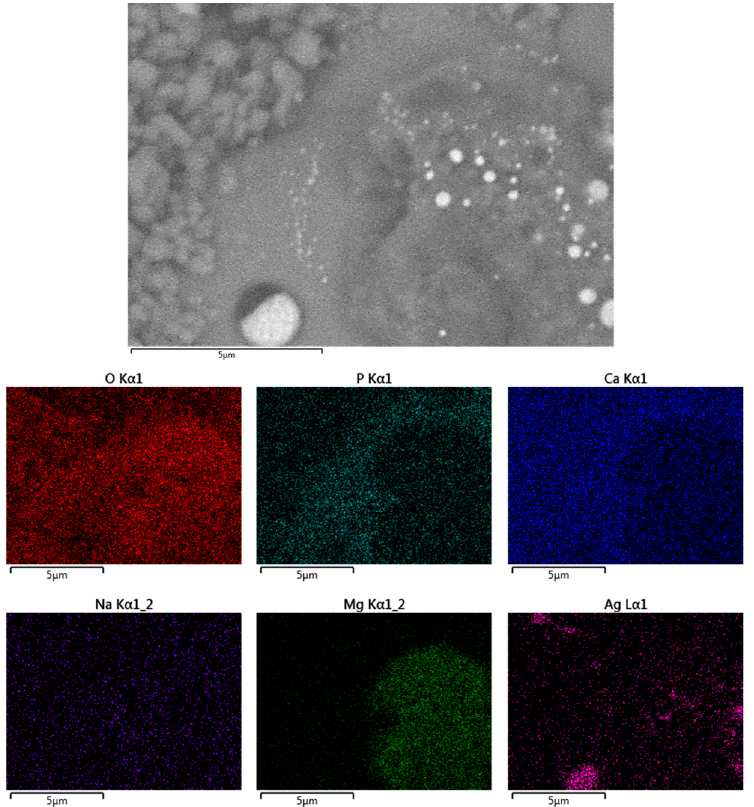
Figure 6. Elemental map of the HA/Ag-NPs coating.